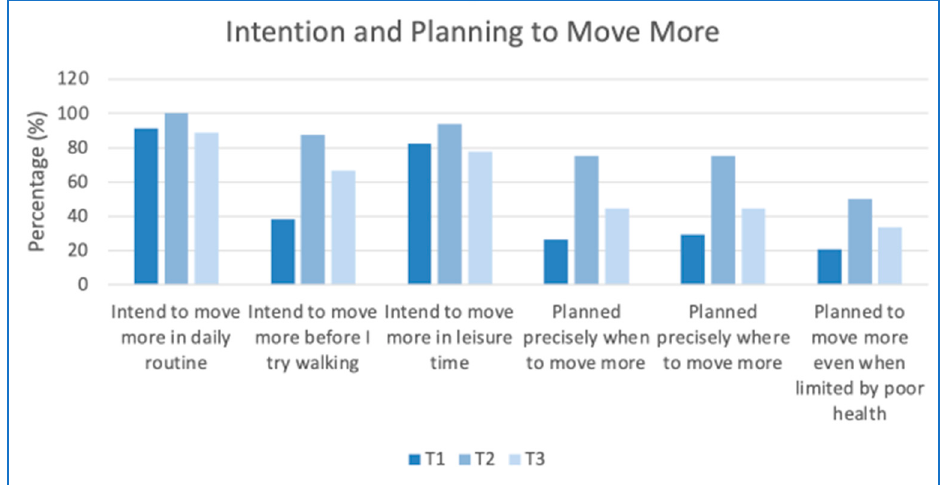
Figure 3. Intention and planning over the 6-month timeframe.